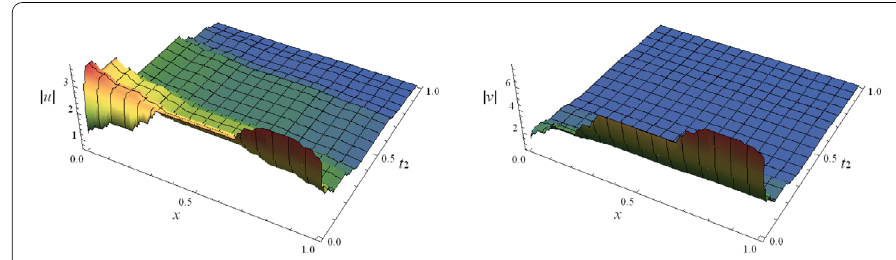
Figure 4 Space-time structures of two-fractal solutions (91) with α = ln2/ln3.